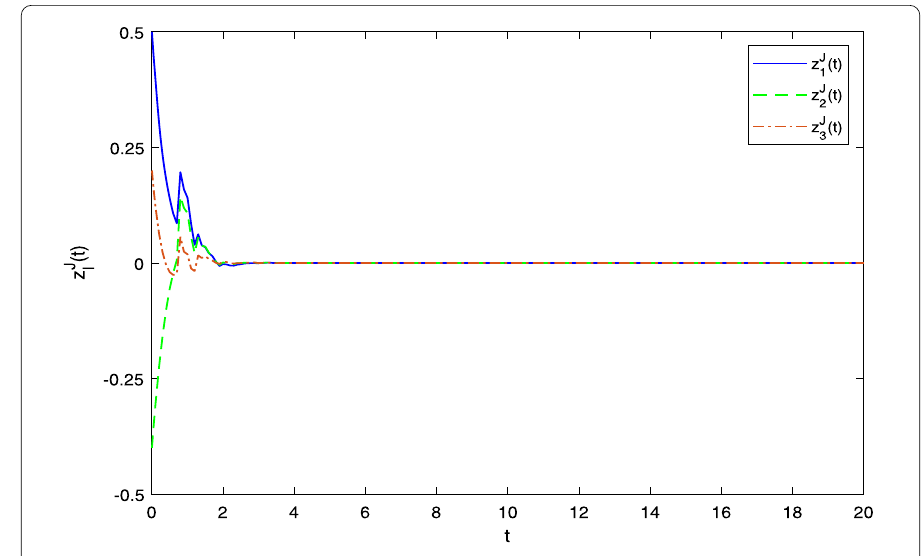
Figure 6 State trajectories of variables z J